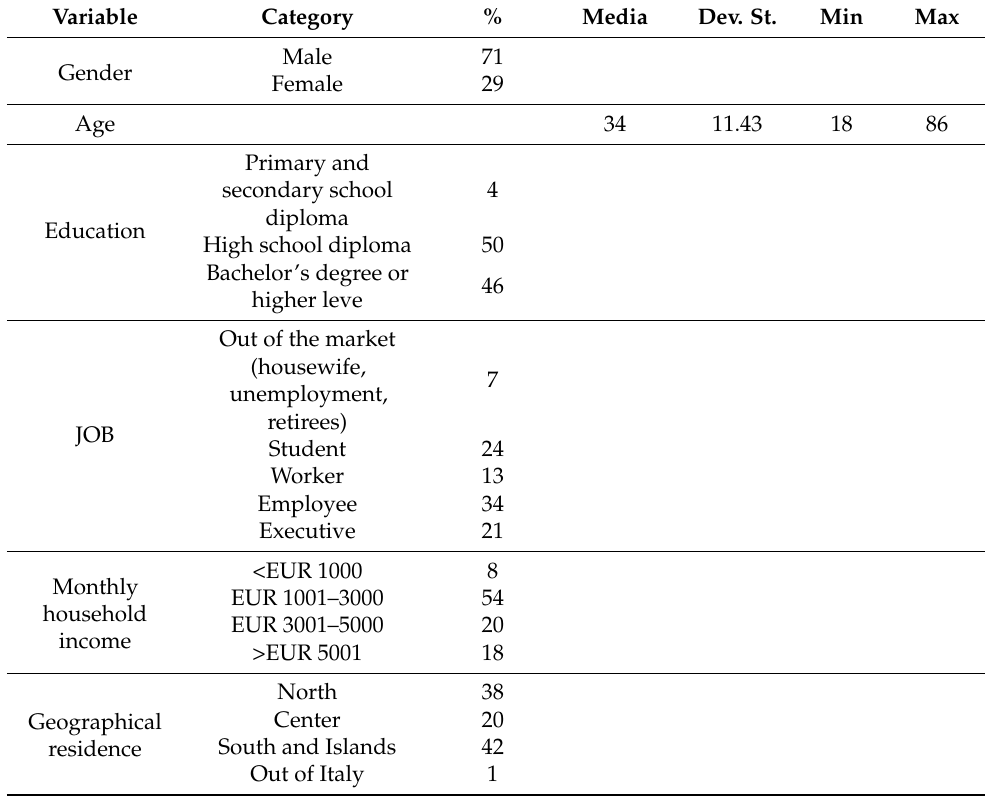
Table 2. Characteristics of the